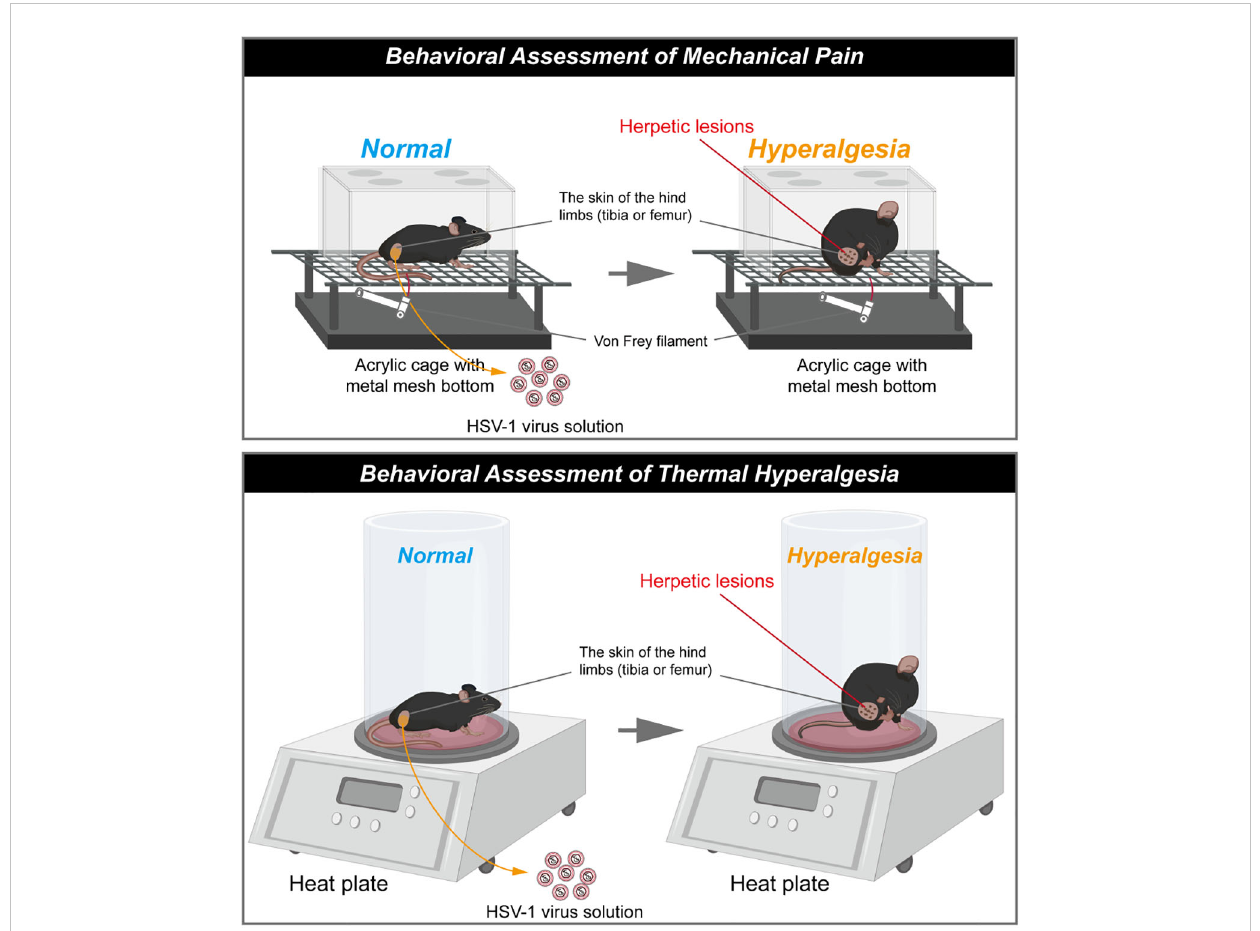
FIGURE 2 Schematic diagram of herpes associated pain model induced by HSV1. (The schematic was drawn by Figdraw, https://www. fi gdraw.com/static/index. html#/).